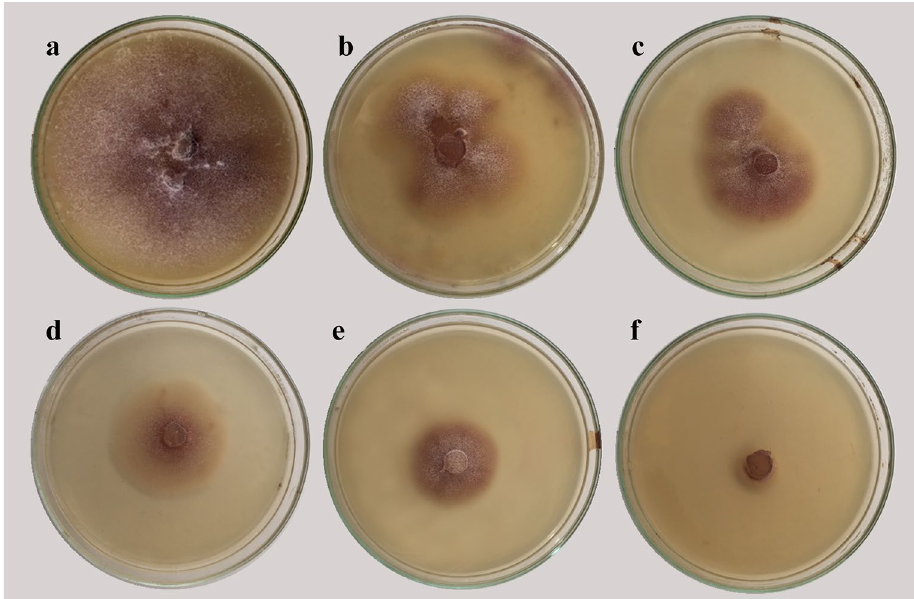
Figure 1. Antifungal activity of lavender essential oil at different concentrations against Fusarium solani in vitro, where a: 0, b: 0.5, c: 0.75, d: 1, e: 1.25, and f: 1.5